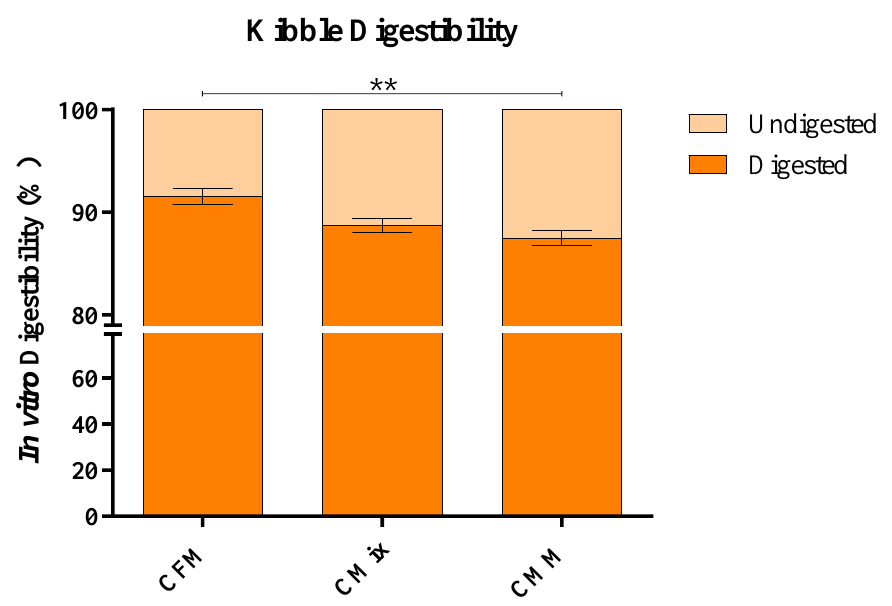
Figure 6. Digestibility of dry samples of CFM, CMix, and CMM formulations for companion animal food analyzed by the in vitro digestibility assay. Data are reported as mean ± SEM, n = 12. ** p < 0.01.